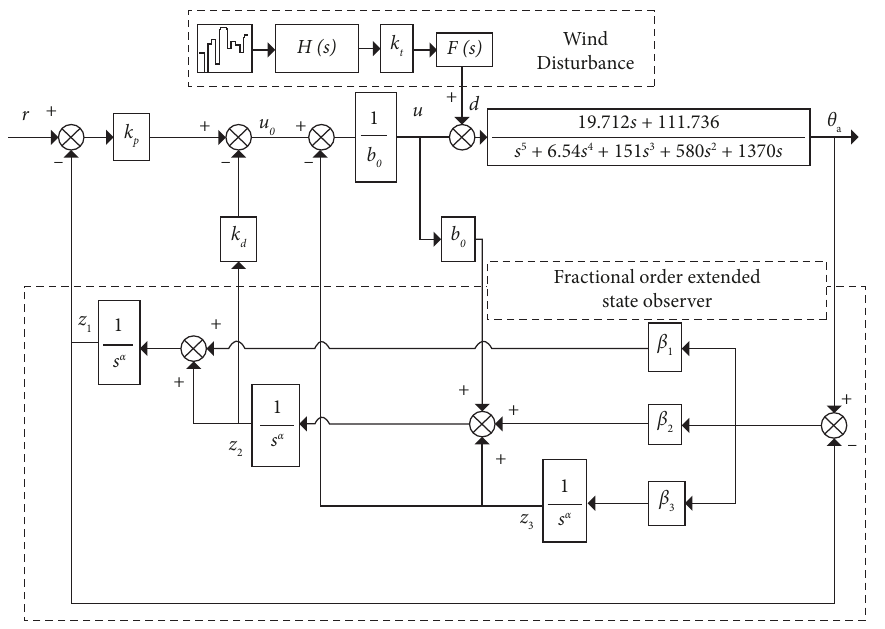
Figure 6: Te proposed structure of FOADRC for the